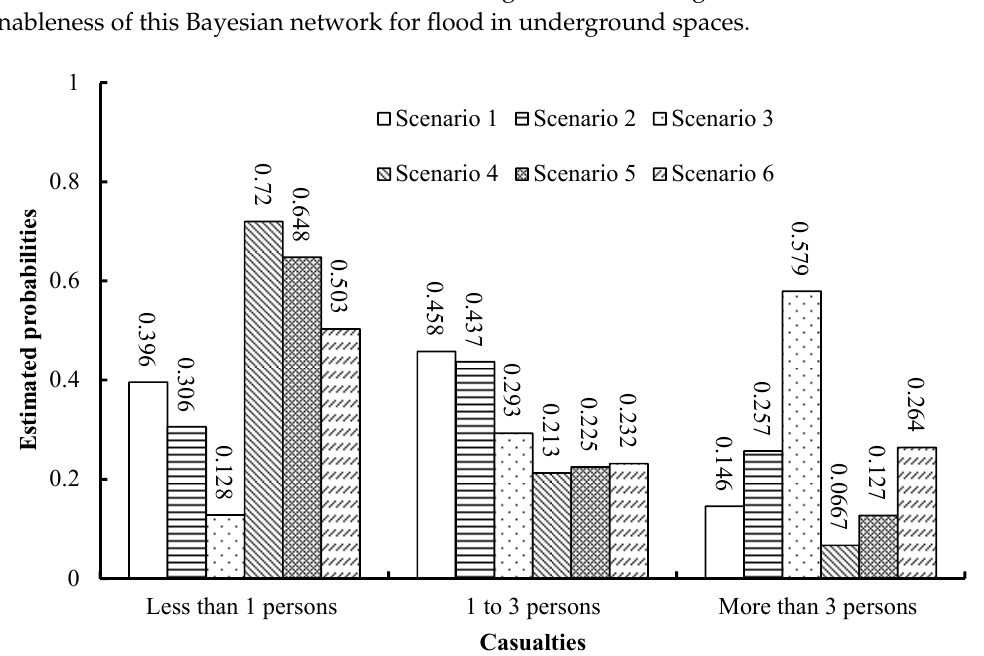
Figure 4. Inference probability of “Casualties”.